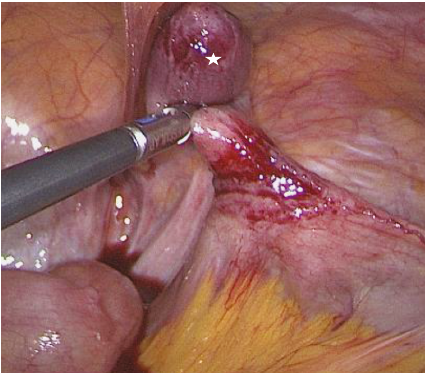
Figure 2: The white star indicates the released Meckel ’ s diverticulum from the